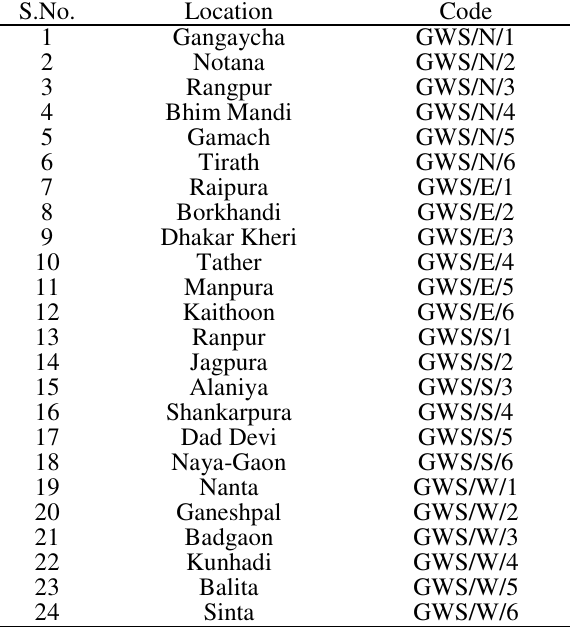
Table 1. Sampling locations and codings of groundwater samples collected at outer skirts of Kota City S.No.